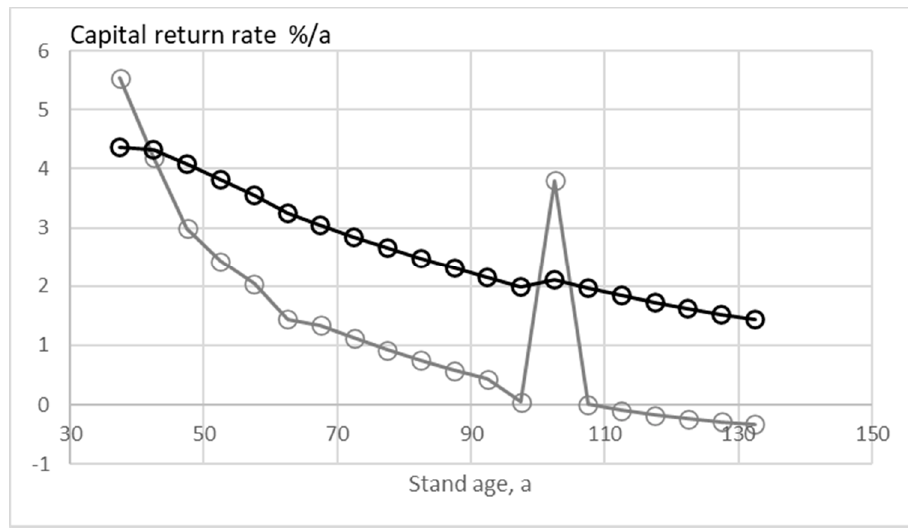
Figure 9. Capital return rate per year (thin drawing) and expected values accumulated over stand age (thick drawing), with thinnings from below.